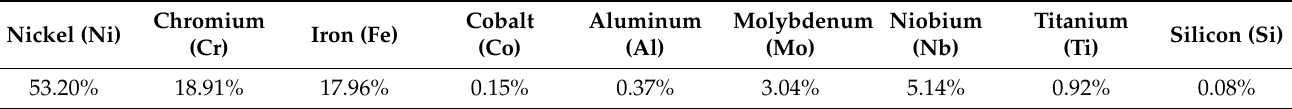
Table 1. Chemical composition of Inconel718 powder (IN718).